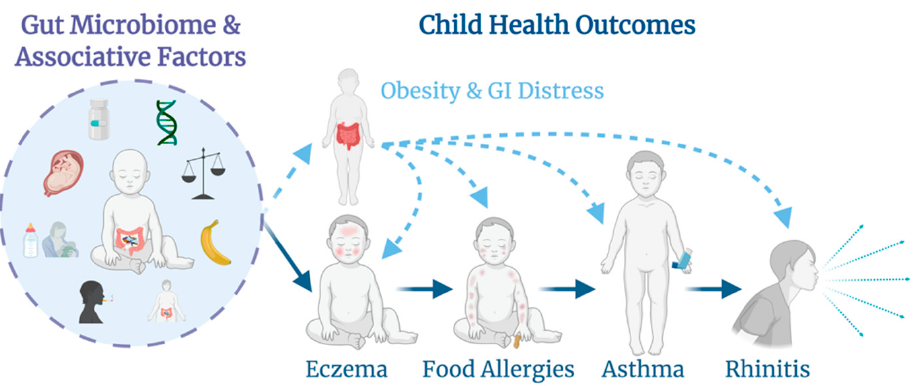
Figure 1. The ARCHBG cohort is designed to study the main exposures associated with the development of the gut microbiome in infancy and how the microbiota development relates to the outcomes of obesity, atopy, and gastrointestinal disease.